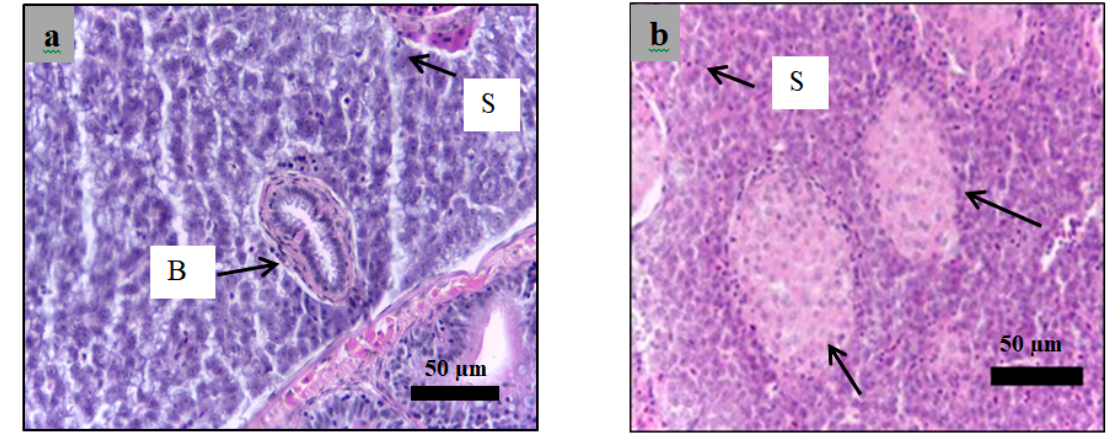
Figure 15. Para ffi n section of zebrafish liver analyzed using hematoxylin and eosin staining for the Figure 15. Paraffin section of zebrafish liver analyzed using hematoxylin and eosin staining for the insulin-treated zebrafish (( a , b ): 40 × magnification). Nodules of damaged hepatocytes are indicated by insulin ‐ treated zebrafish ( a , b : 40× magnification). Nodules of damaged hepatocytes are indicated by arrows. B: bile ductules, S: sinusoidal Figure 15. Paraffin section of zebrafish liver analyzed using hematoxylin and eosin staining for the arrows. B: bile ductules, S: sinusoidal spaces. insulin ‐ treated zebrafish ( a , b : 40× magnification). Nodules of damaged hepatocytes are indicated by Figure 15. Paraffin section of zebrafish liver analyzed using hematoxylin and eosin staining for the arrows. B: bile ductules, S: sinusoidal spaces. insulin ‐ treated zebrafish ( a , b : 40× magnification). Nodules of damaged hepatocytes are indicated by arrows. B: bile ductules, S: sinusoidal spaces.